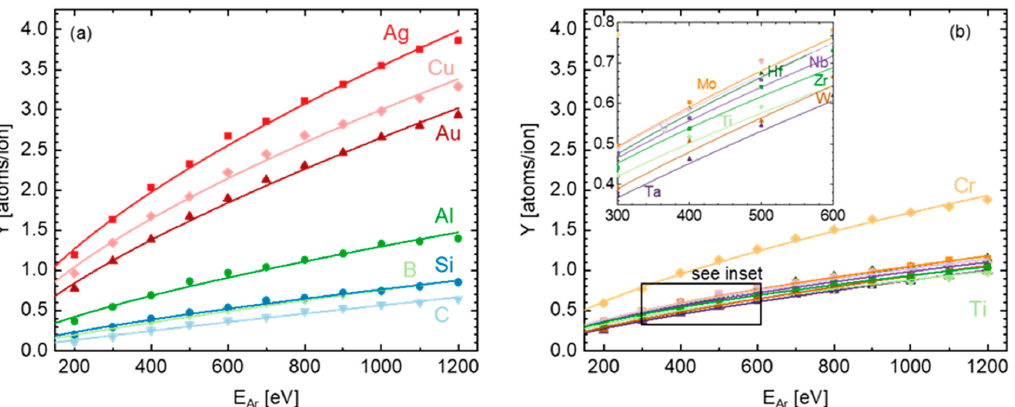
Figure 3. The total sputtering yield in dependence of Ar ion energy simulated by the SRIM program for different elements for normal ion impingement. For clarity, the elements are shown in two separate graphs at identical scales: ( a ) elements from groups 11, 13, and 14; ( b ) elements from groups 4–6. Due to minor differences, an inset is shown at an enlarged scale.